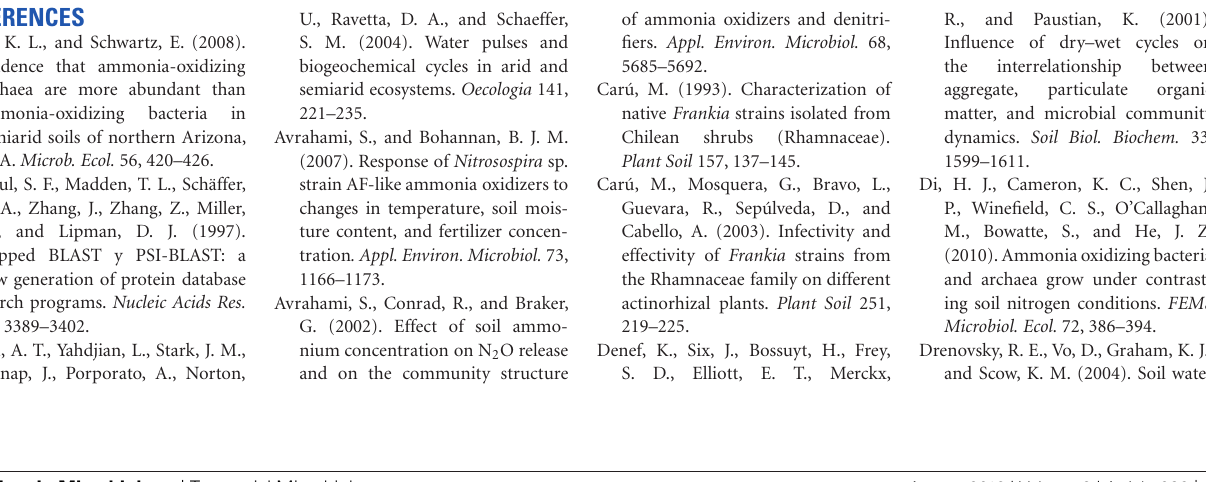
days(tH2O)duringtheincubationtime. Thedifferenttexturesrepresent differentT-RFsinbasepairs(bp).Ateachincubationtime,relativeabundances ofT-RFsarenotsignificantlydifferent(Bonferroni’stest, p < 0 .